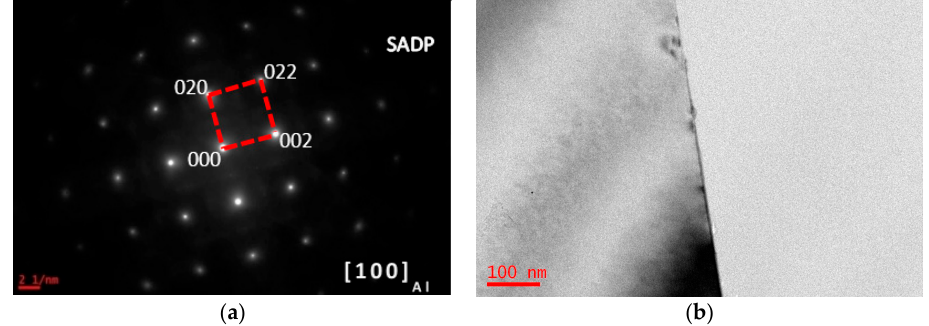
Figure 1. Microstructure and selected area diffraction patter (SADP) of the sample having been solution treated at 470 °C for 1 h. ( a ) SADP of the sample, beam along to zone axis of [100] Al ; solution treated at 470 ◦ C for 1 h. ( a ) SADP of the sample, beam along to zone axis of [100] Al ; ( b ) bright-field image. ( b ) bright-field